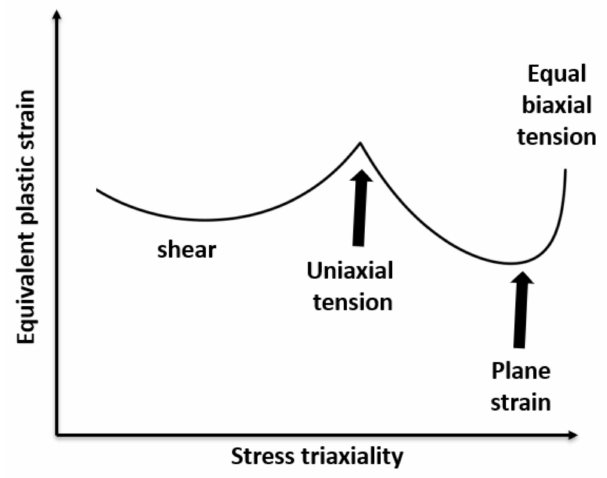
Figure 1. Dependency of fracture strain on stress triaxiality under various stress states for a typical steel